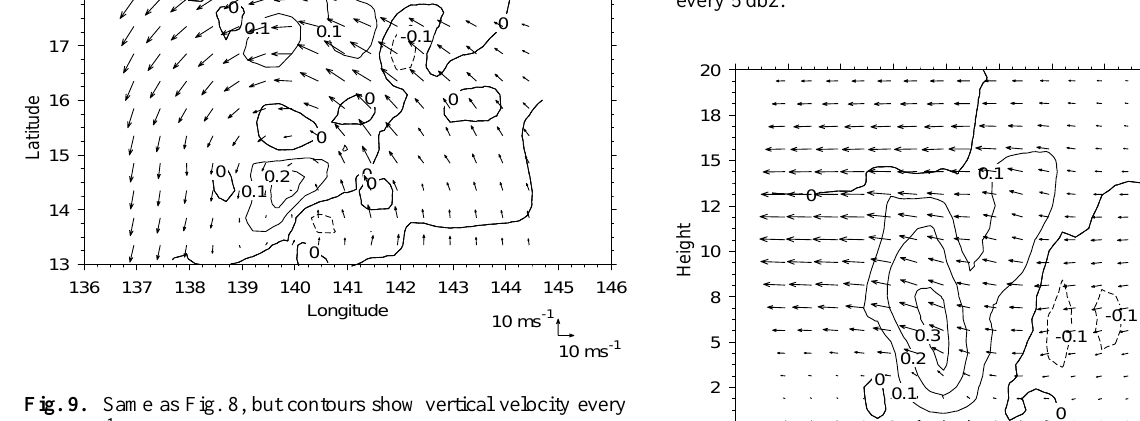
Fig. 10. Results of the synthesis using radar data only. A vertical cross section at latitude 14 . 5 ◦ is displayed. The arrows show the projection of the Earth-relative wind field, while colors and contours show the reflectivity field. The scales for the zonal and vertical winds are indicated at the bottom of the plot. Contours are shown every 5dbz.